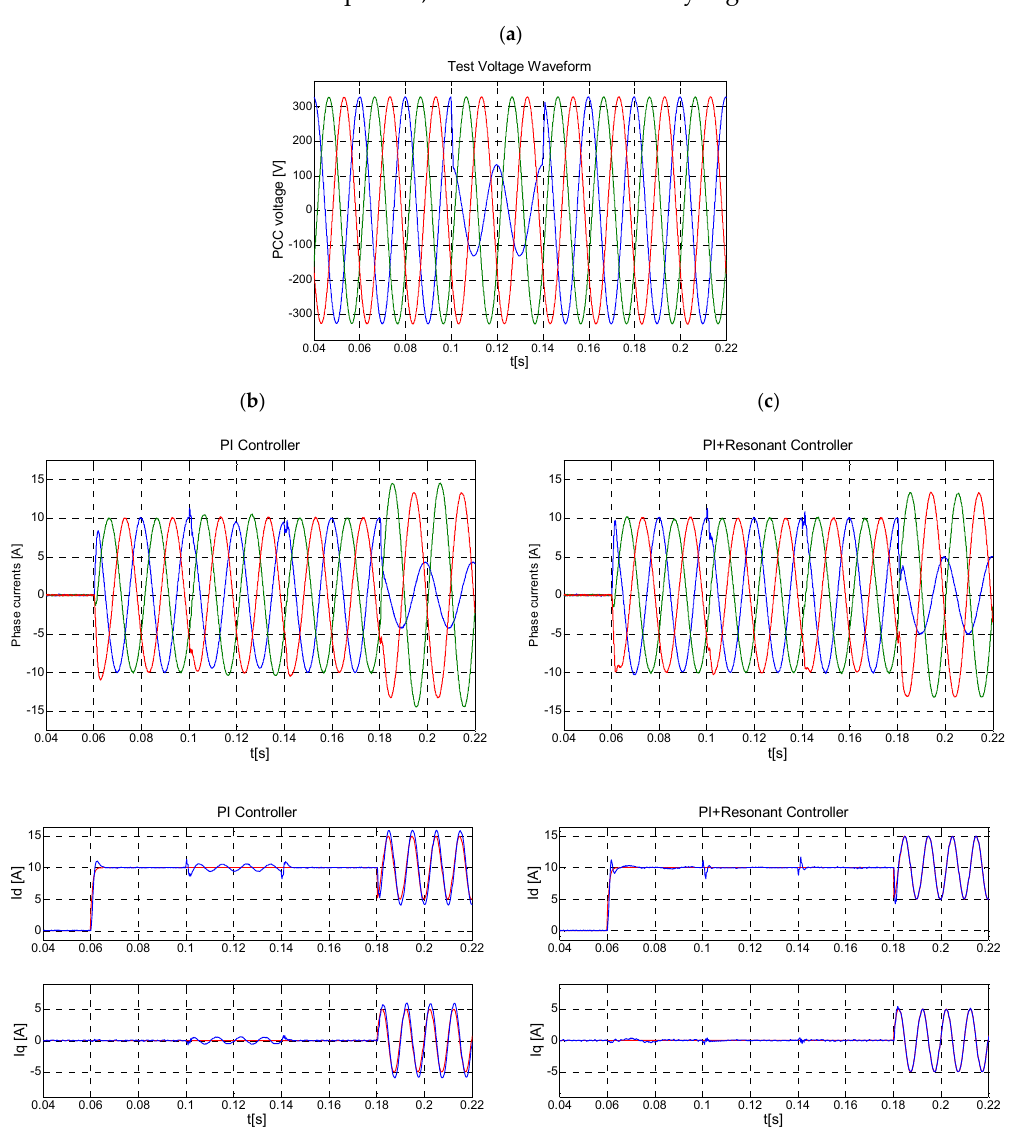
Figure 7. Simulation results of the current controller operating under unbalanced voltage conditions: ( a ) test voltage waveform, ( b ) PI controller and ( c ) proposed PI and resonant controller.